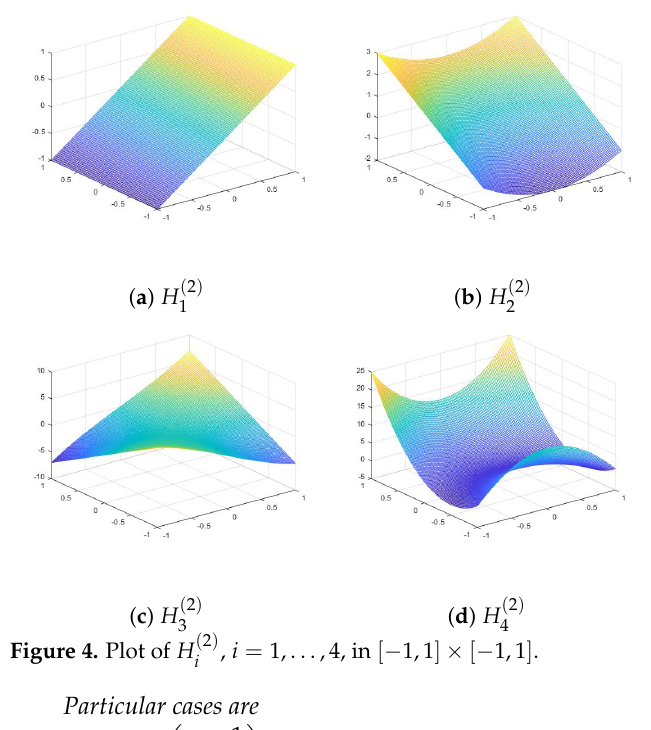
Figure 4. Plot of H